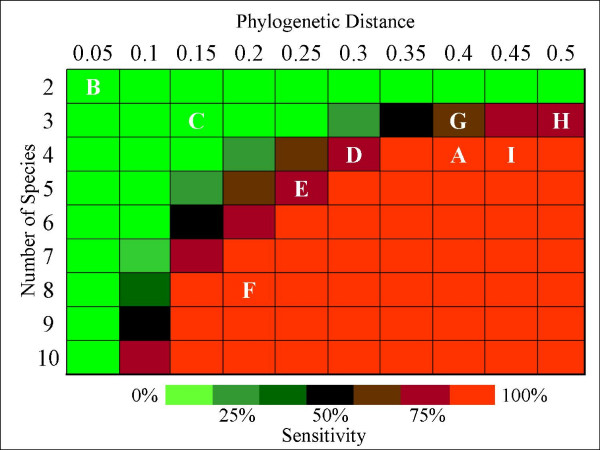
Sensitivity of the likelihood comparison on simulated data. Colors represent method's sensitivity with different numbers of species at different evolutionary distances (measured in substitutions per site). Letters represent approximate placement of commonly compared organisms. A: Yeast species used (96.964 % sensitivity) B : Human – Chimp (0 %) C : Human – Mouse – Rat (0 %) D : Human – Mouse – Rat – Chicken (83.489 %) E : Human – Mouse – Rat – Chicken – Dog (89.536 %) G : T. nigroviridis – T. rubripes – D. Rerio (68.372 %) H : C. elegans – C. brigssae – C. remanei (86.561 %) F : Human – Baboon – Cat – Dog – Cow – Pig – Mouse – Rat (98.761 %) I : D Melanogaster – D. simulans – D. yakuba – D. psuedoobscura (98.564 %).